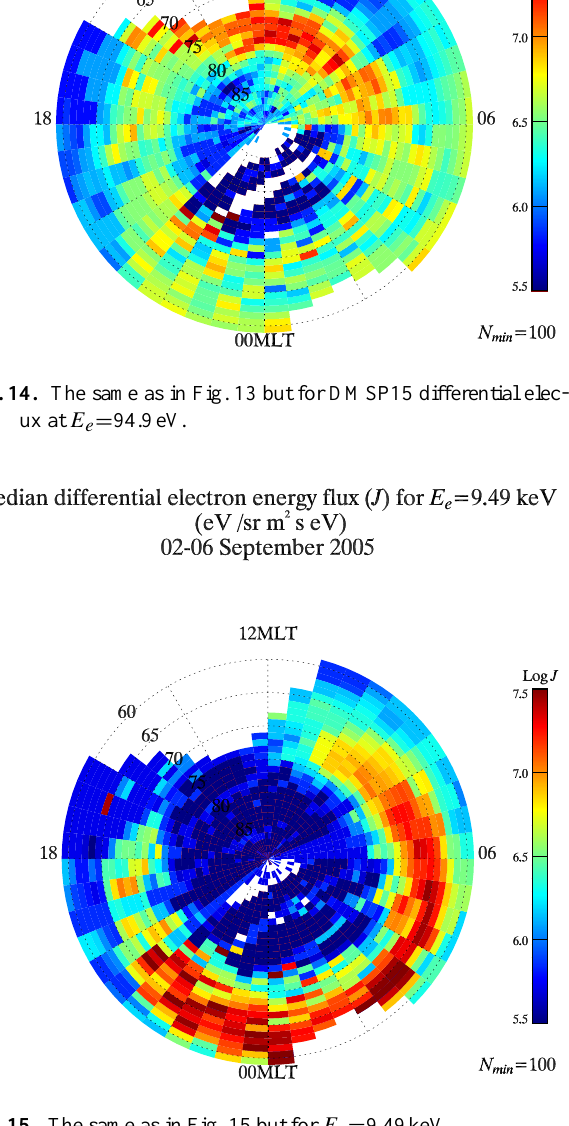
Fig. 15. The same as in Fig. 15 but for E e =